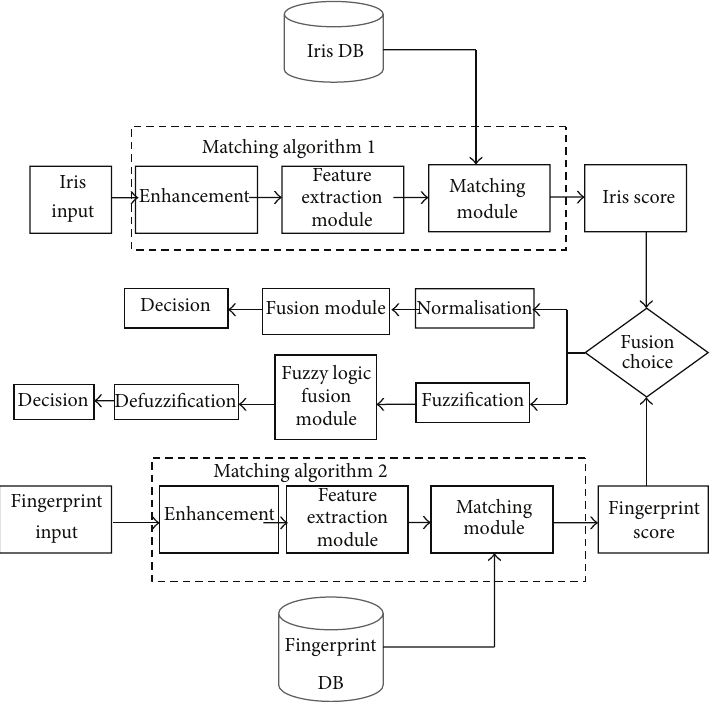
Figure 3: Flow chart of the application showing the main modules of the multimodal biometric recognition system.